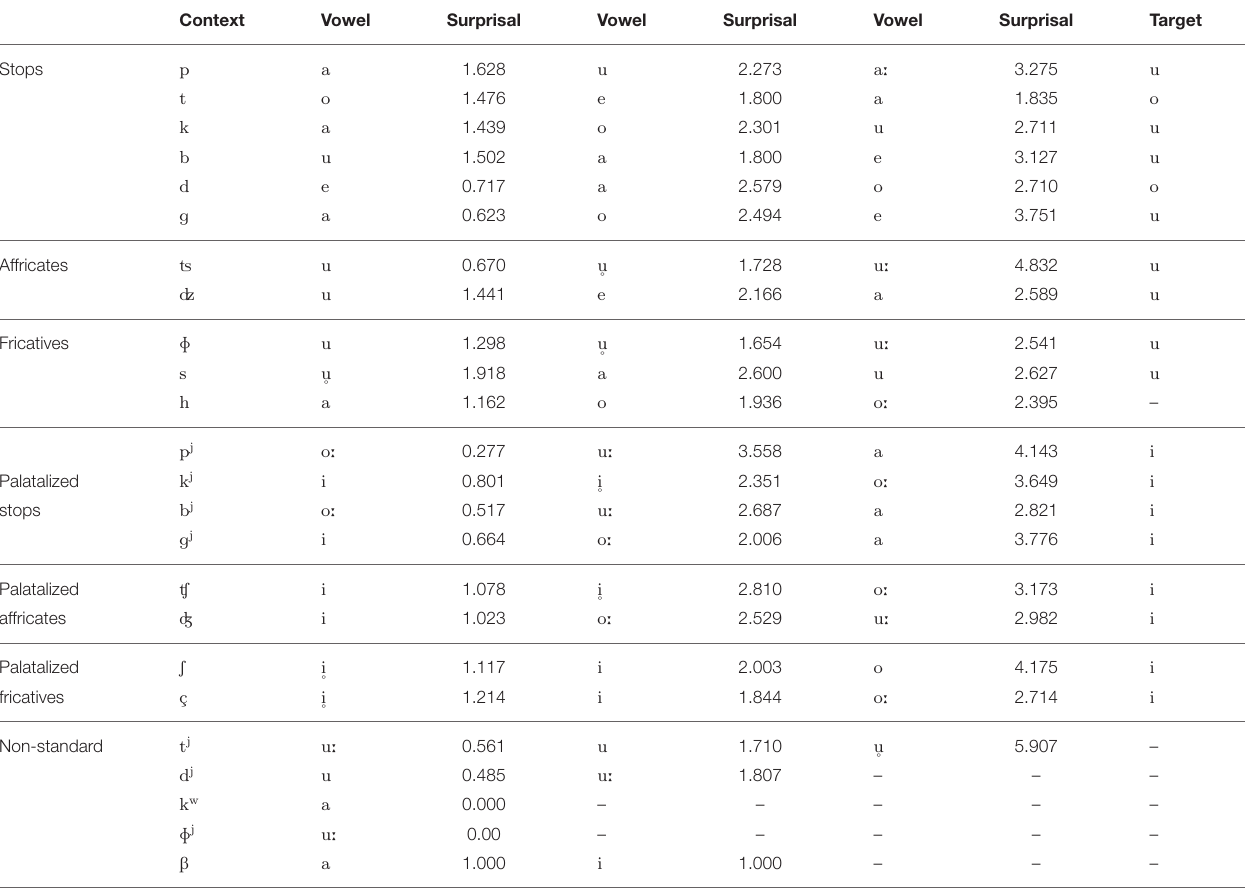
TABLE 2 | Vowels with the three lowest surprisal after all obstruents observed in the CSJ-RDB, in order of increasing surprisal.